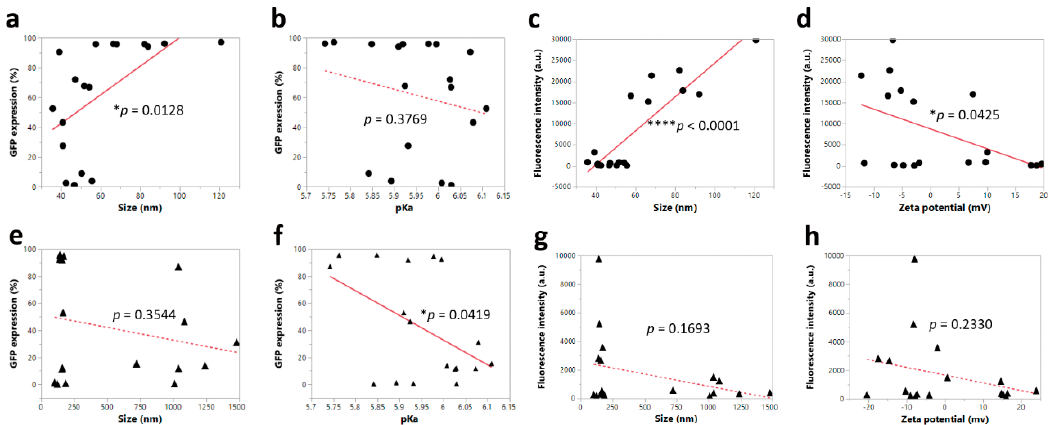
Figure 8. Orthogonal trends of intracellular protein expression in terms of percent GFP expression and fluorescence intensity, whereby dotted line represented non-significance and solid line represented significance. ( a – d ): Correlation between intracellular protein expression and formulation properties before nebulization. ( e – h ): Correlation between intracellular protein expression and formulation properties after nebulization. (* p < 0.05, and **** p < 0.0001) For effective pulmonary drug delivery, LNP-mRNA formulations must be stably aerosolized.